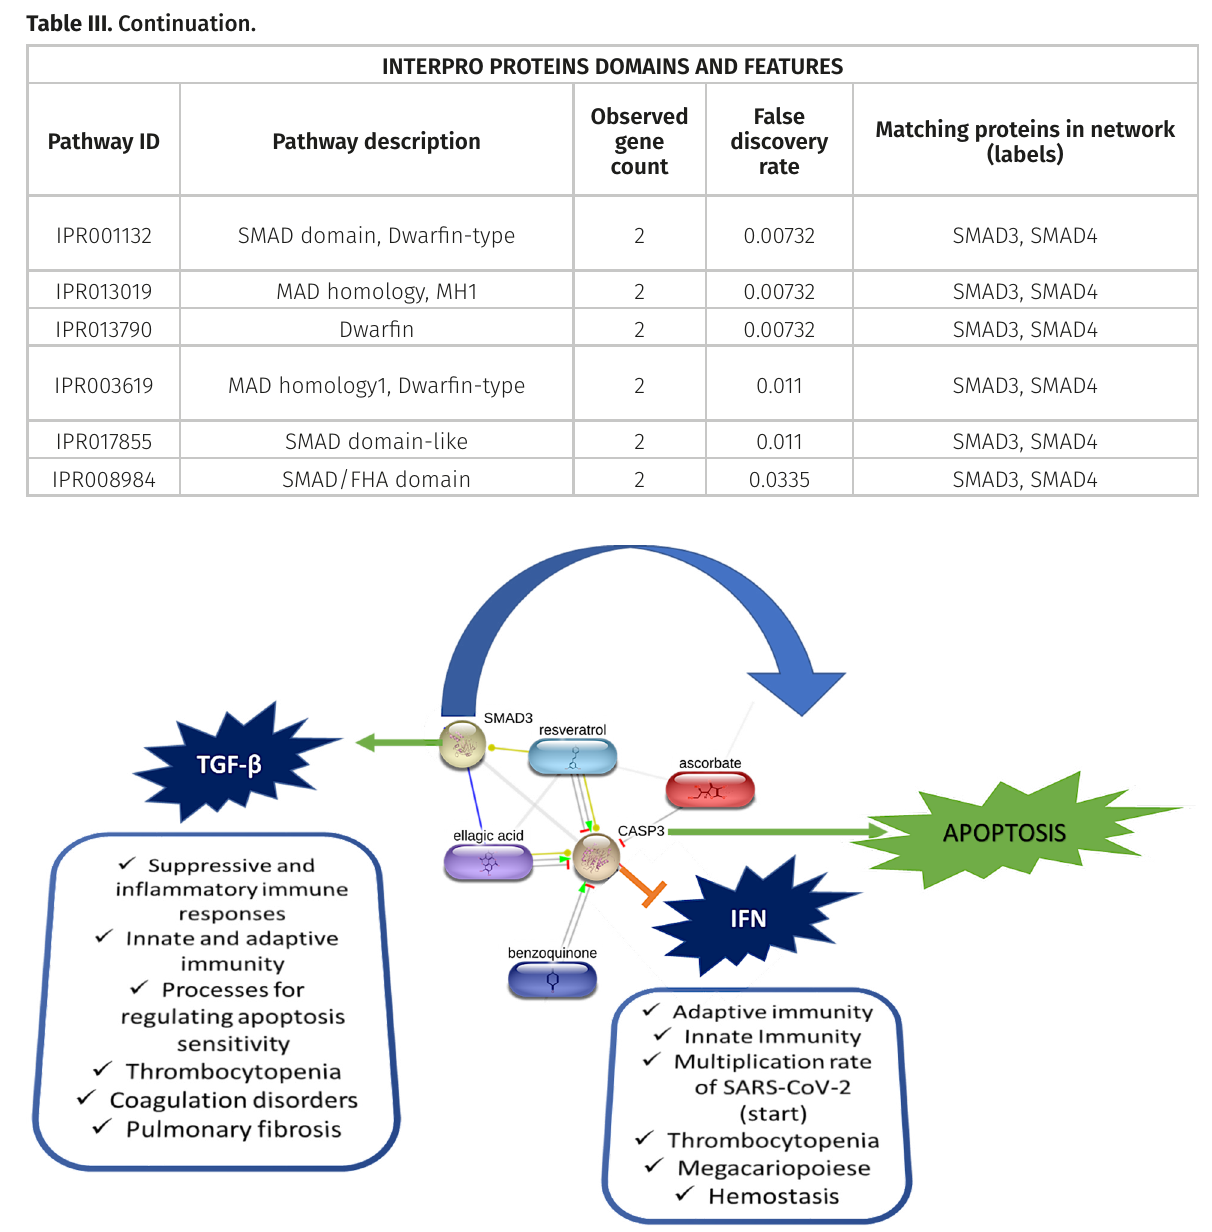
Figure 4. Representation of events that can be regulated by the action of the compounds ascorbate, benzoquinone, ellagic acid, and resveratrol on the leader genes CASP3 and